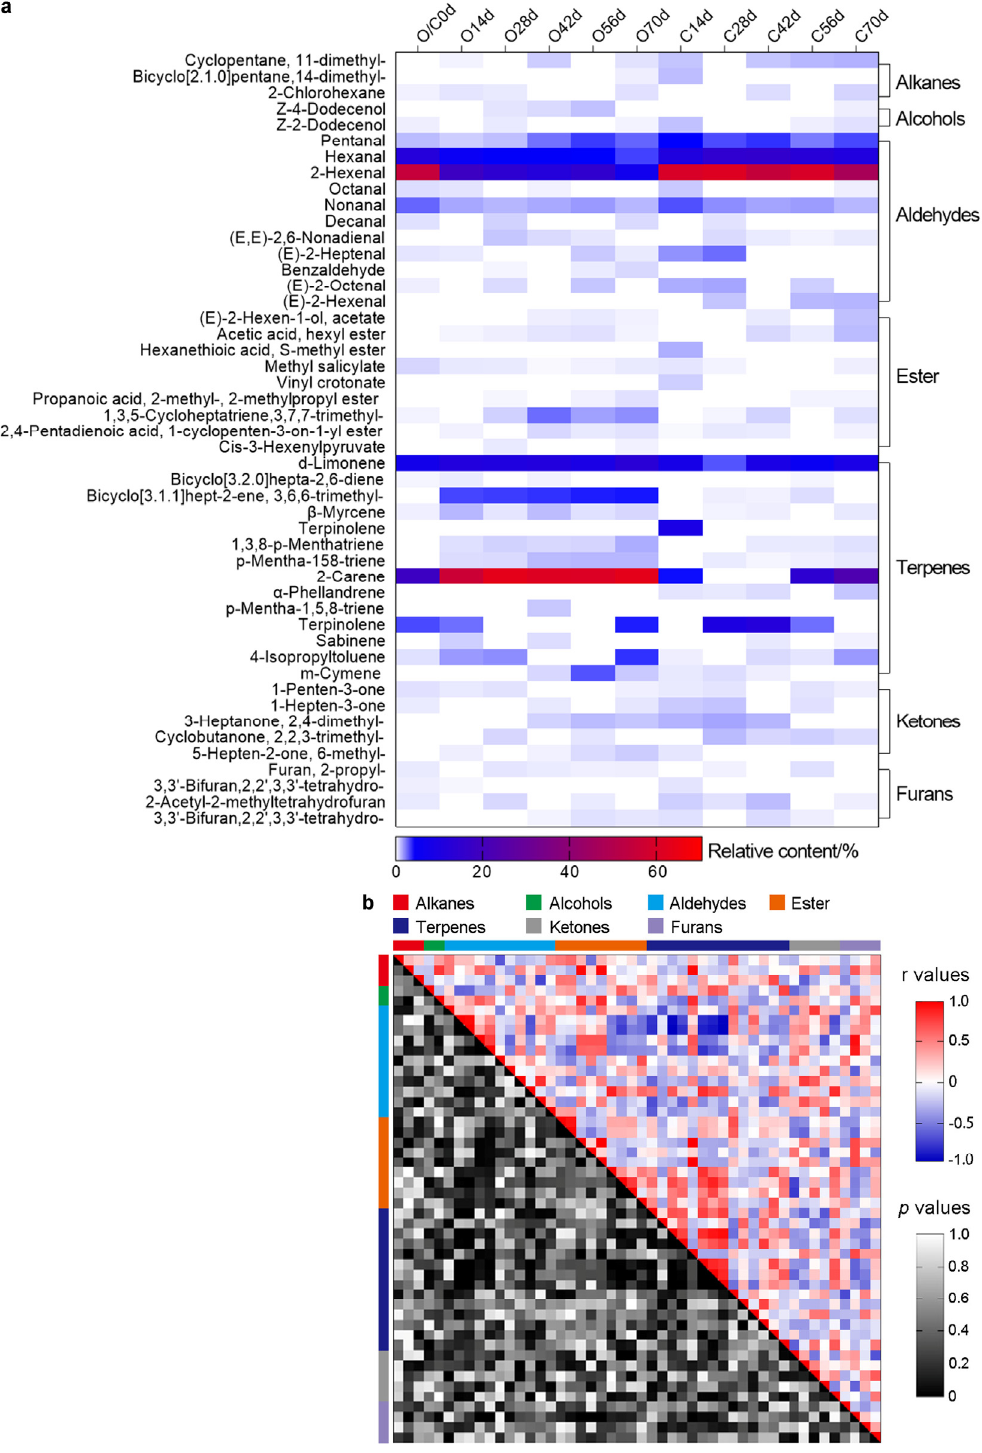
Figure 6. Identification and analysis of aroma components. ( a ) The relative content of aroma components in ‘Ganlv-2’ of different softening methods. ( b ) Aroma compounds correlation/significance of on-vine and cold group. In the colored area, rectangles represent r values resulting from Pearson correlation coefficient computation (see correlation color key). In the black and white area, rectangles represent p values respective to Pearson correlation coefficient (see Significance color key). Z − score transformation was employed to enable correlation computation. Note: ‘O’: on-vine group; ‘C’: cold group.